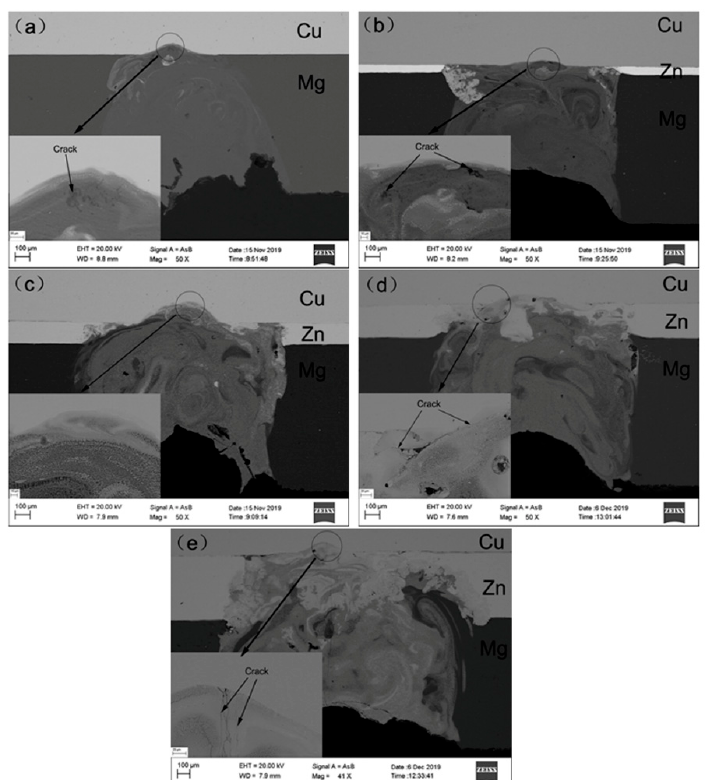
Figure 2. Welding joints with Zn interlayers of different thicknesses: ( a ) Direct welding; ( b ) 0.05 mm; ( c ) 0.1 mm; ( d ) 0.2 mm; ( e ) 0.5 mm.